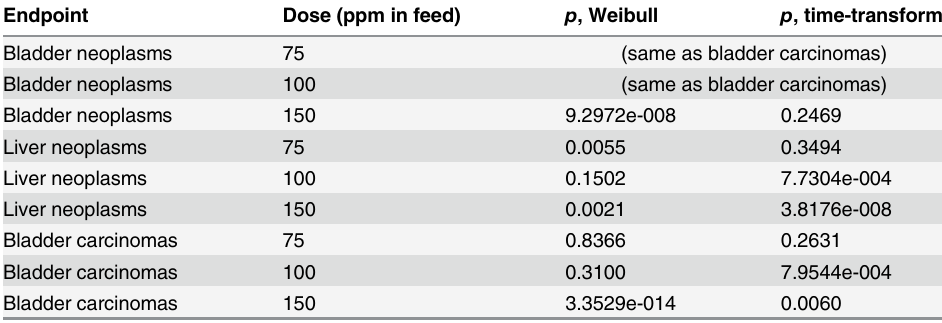
Table 3. Fits of the ED 01 Data on Sacrificed, Moribund, and Dead Mice to the Weibull and Time-Trans- form Distributions.